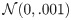
One thousand opinion agents, 20000 iterations, μ = .2, d = .4, tolerance .5, noise from N(0,.001).(a) Stacked histograms of uniformly distributed agents (top) in continuous opinion space with a fairly assigned, heterogeneous binary “color” attribute, preferring not to be a minority “color” in a neighbourhood of their opinion arrange themselves in cleavages with two modes (bottom), (b) Two dimensional histogram of evolution in time.